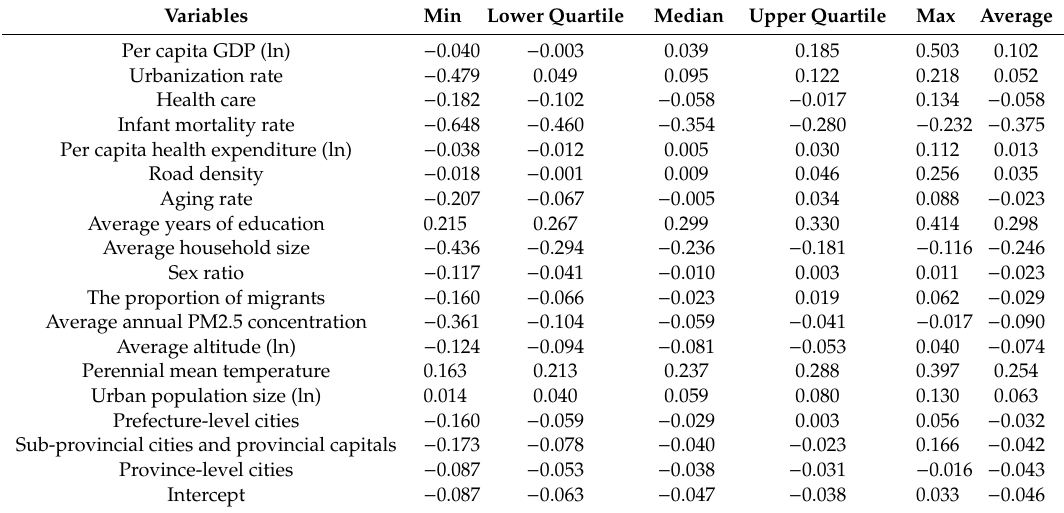
Table 5. Descriptive analysis of the GWR model regression coe ffi